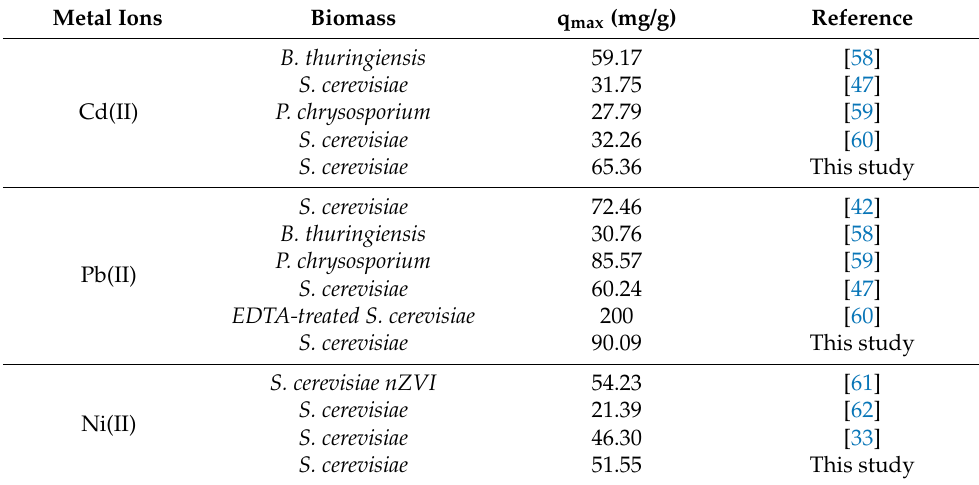
Table 3. The maximum adsorption capacity (q max ) of various biosorption capacities of biomass discovered in this research was compared to those published in the literature for Cd(II), Pb(II), and Ni(II),